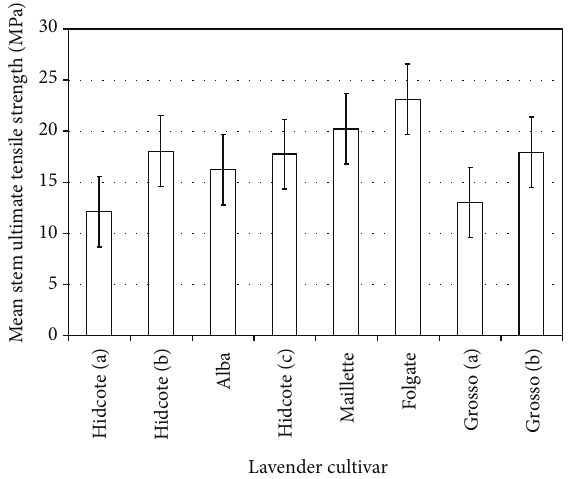
Figure 6: Mean stem ultimate tensile stress for the eight lavender crop samples showing overall mean of 95% confidence limits.